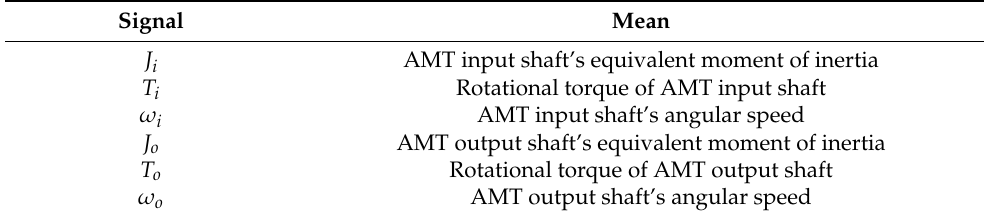
Table 1. Model Table 1. Model parameters.